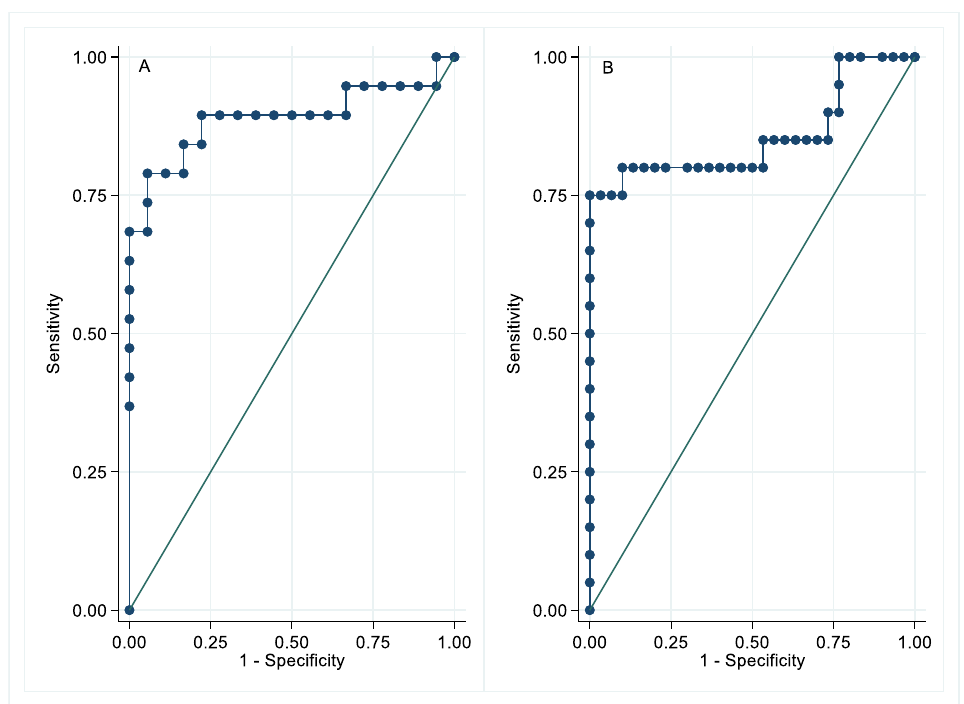
Figure 2. Receiver operating characteristic (ROC) curves of neurofilament light chain (NFL). ( A ) ROC curve of cerebrospinal fluid NFL levels between neurosarcoidosis (NS) patients versus extra-neurologic sarcoidosis (ENS) patients and healthy controls (HCs). The area under curve 0.8889, p = 0.05. ( B ) ROC curve of plasma NFL levels between NS patients versus ENS patients and HC. The area under curve 0.8550, p =